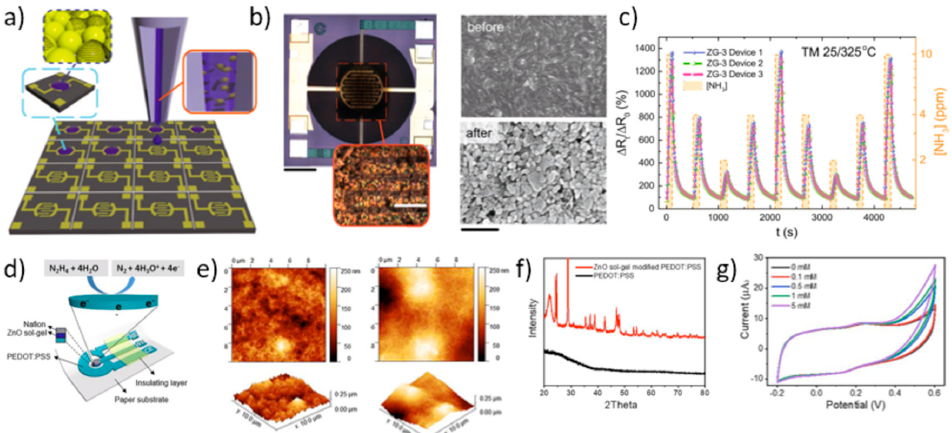
Figure 15. Applications in chemosensors. ( a ) Schematic representation of the graphene-ZnO inkjet printing deposition process over multiple CMOS µ HPs. ( b ) Optical micrograph of a single inkjet-printed device (scale bar 200 µ m), and magnification of the graphene-ZnO NP film over the Au interdigitated electrodes (IDEs, scale bar 20 µ m) (left panel); scanning electron microscope (SEM) image of the graphene-ZnO composite film before and after thermal annealing (right panel). ( c ) Device response curves by the temperature-modulation scheme upon nine pure NH 3 injection cycles (10, 4, and 2 ppm) (3 wt% graphene sample, ZG-3). Reprinted from reference [124] under a Creative Commons Attribution 4.0 International License. ( d ) All inkjet-printed PEDOT:PSS / ZnO sensor for hydrazine detection, schematic structure. ( e ) AFM images of PEDOT:PSS / ZnO (left panel), and PEDOT:PSS (right panel) electrode surfaces. ( f ) X-ray di ff raction (XRD) spectra of PEDOT:PSS / ZnO (red) and PEDOT:PSS (black line) electrodes. ( g ) CV response of the PEDOT:PSS / ZnO electrode sensor in the presence of di ff erent concentrations of hydrazine (0 mM to 5 mM). Reprinted from Reference [125], Copyright (2020), with permission from